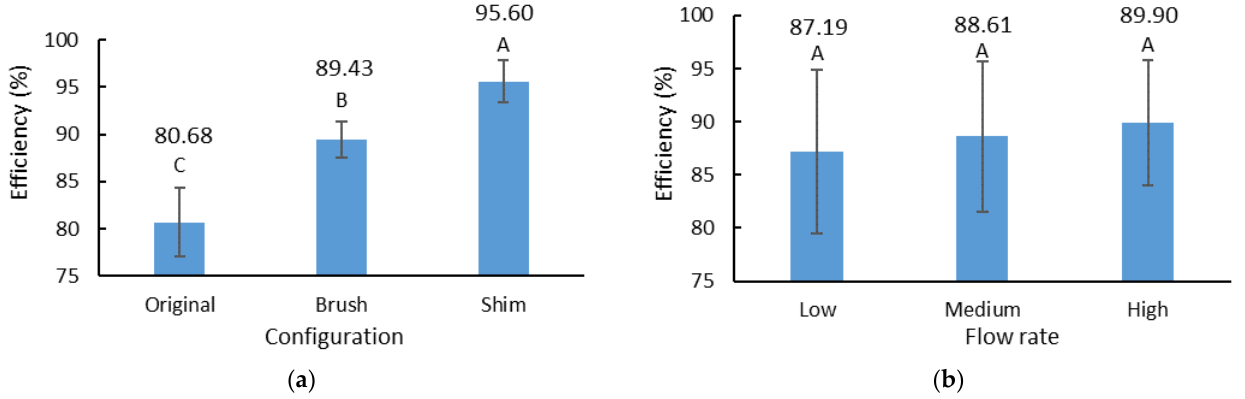
Figure 8. Material- conveying efficiency of different auger configurations ( a ) at different mass flow rates ( b ). Means followed by different letters are significantly different according to Duncan’s multiple range test at the significance level of 0.05, and error bars are standard deviations.